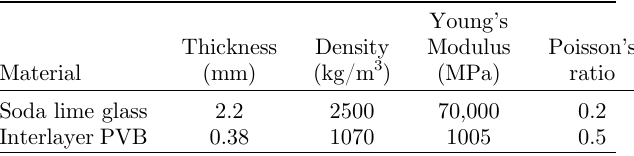
Table 1. Acoustic parameters of the inspected glass layers, acquired from the product datasheet.